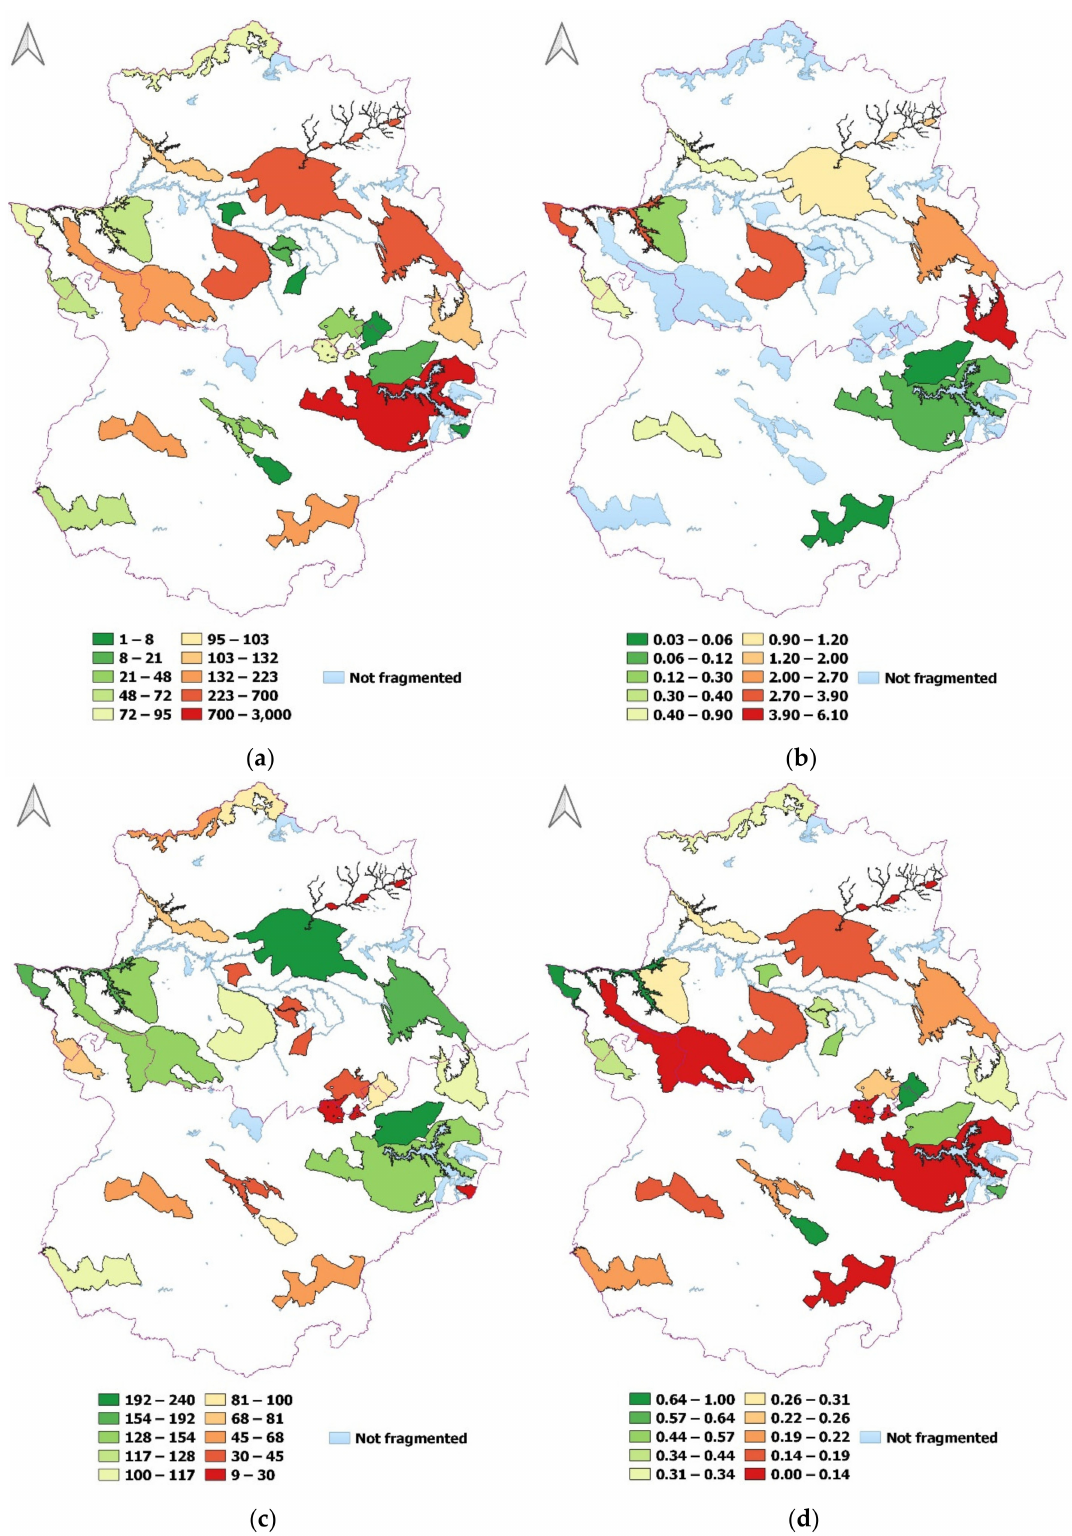
Figure 7. Landscape metrics obtained in relation to the Special Bird Protection Areas (SPAs) in Extremadura (Spain): ( a ) IFI, ( b ) UFI, ( c ) M eff (km 2 ) and ( d )